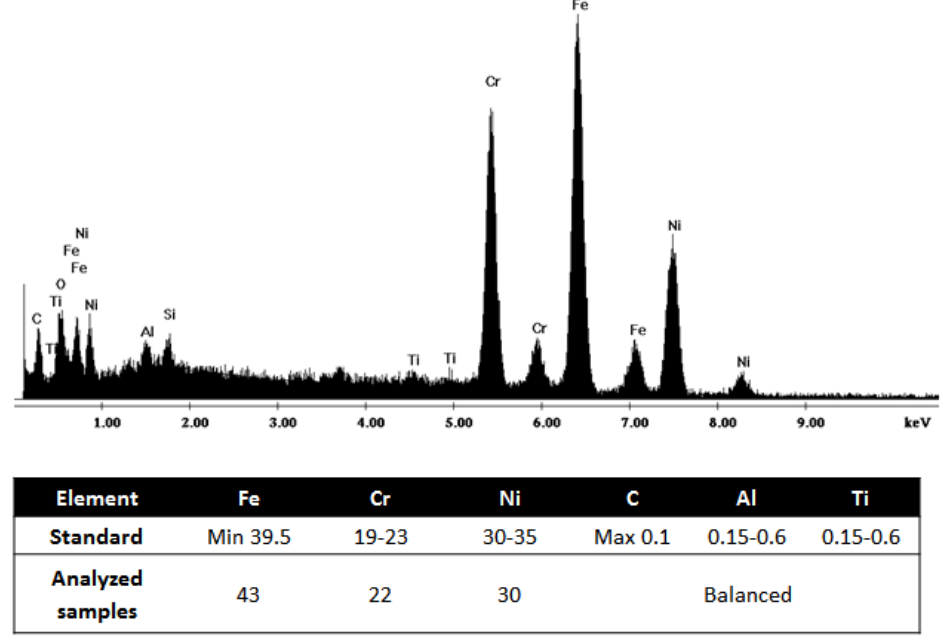
Figure 5. Chemical composition of the reference material as well as the samples using EDS analysis .